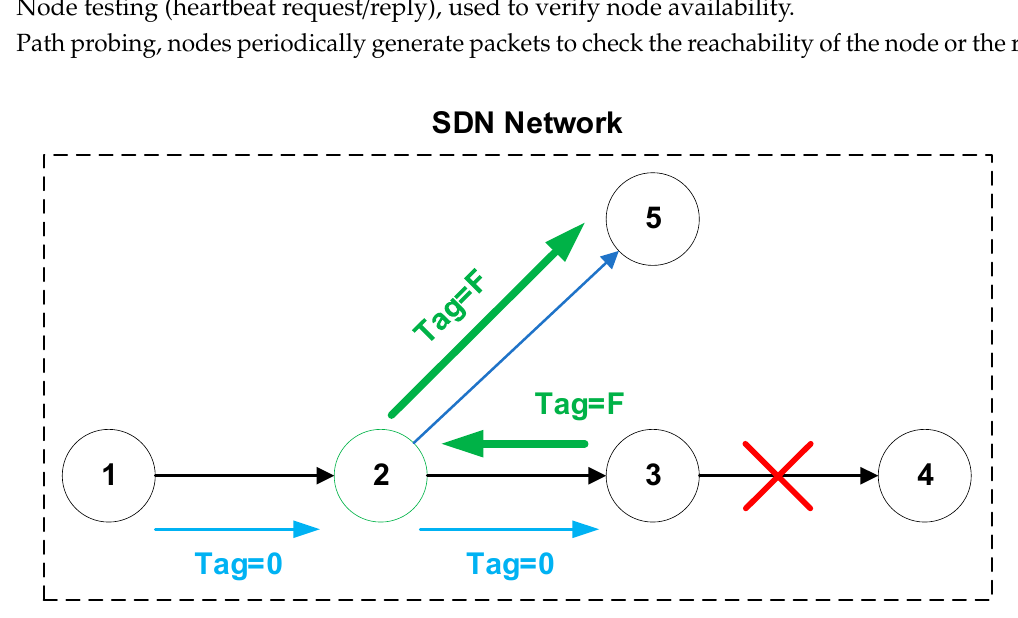
Figure 3. SPIDER—remote failover method.